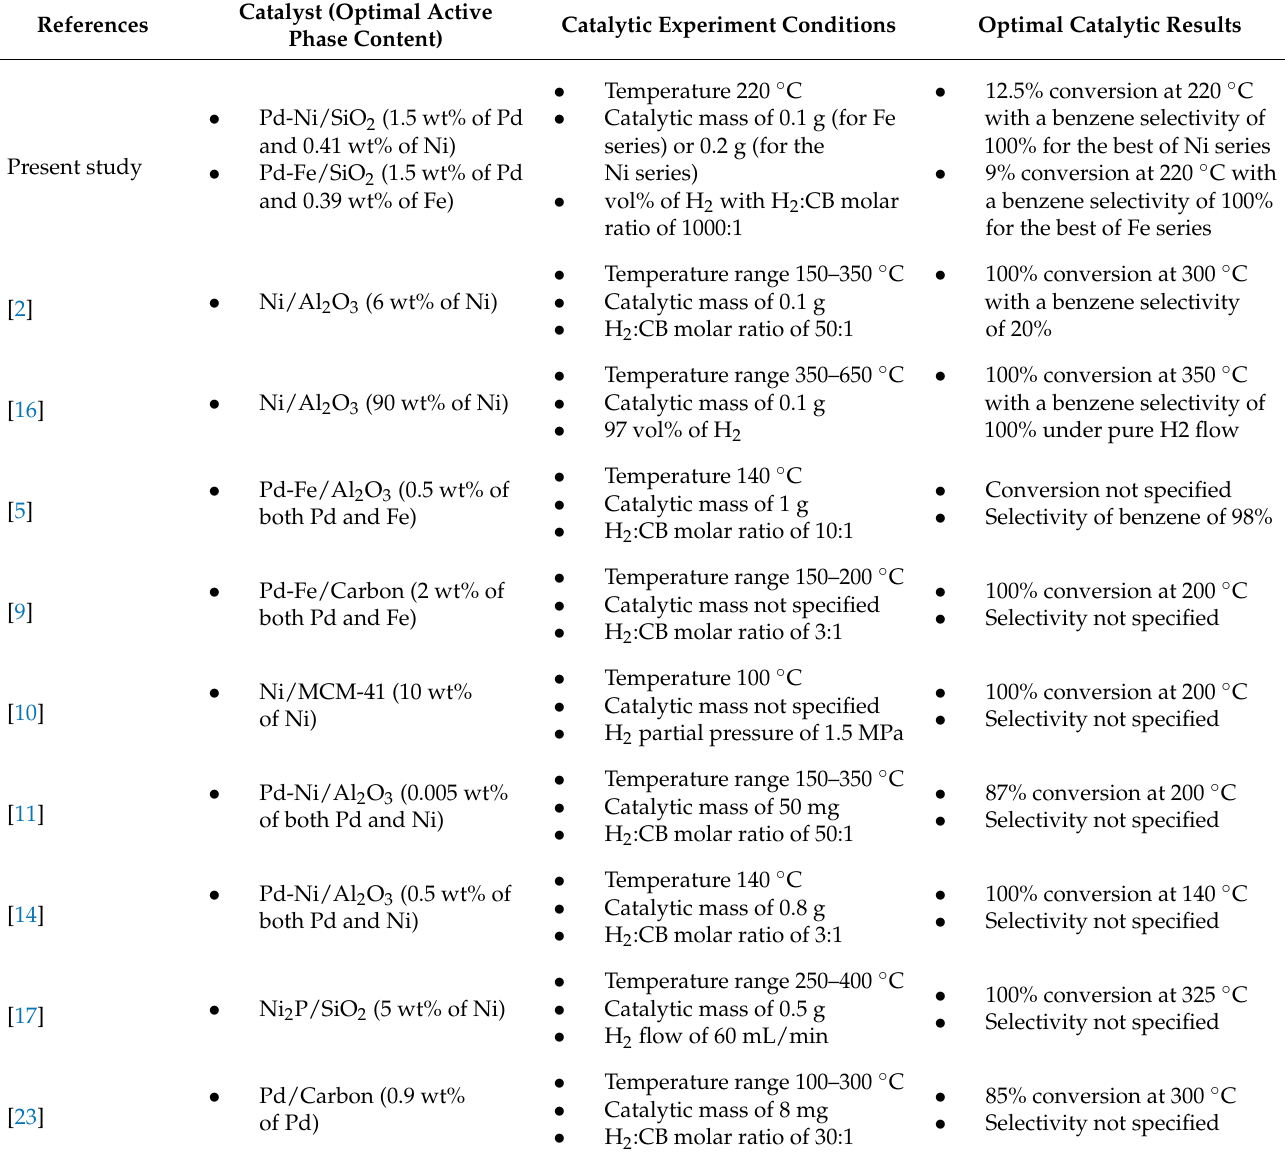
Table 4. Comparison of the chlorobenzene (CB) catalytic activity with the